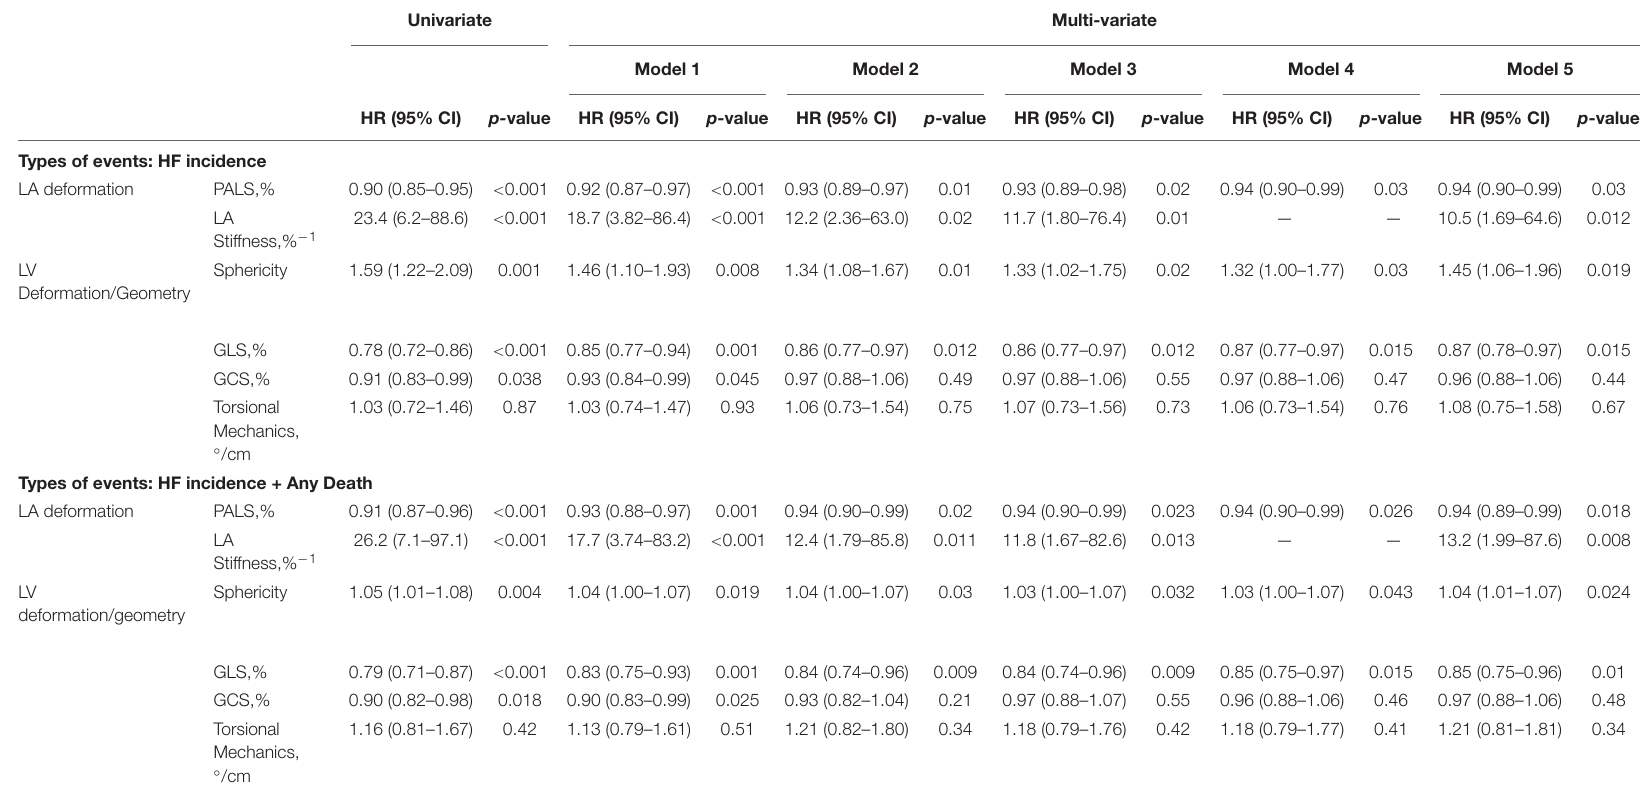
Model 1: adjusted for age. Model 2: adjusted for age, BMI, heart rate, SBP, eGFR, hypertension, diabetes, CAD and active smoking. Model 3: adjusted for age, BMI, heart rate, SBP, eGFR, hypertension, diabetes, CAD and active smoking, LVEF. Model 4: adjusted for age, BMI, heart rate, SBP, eGFR, hypertension, diabetes, CAD and active smoking, E/e’. Model 5: adjusted for age, BMI, heart rate, SBP, eGFR, hypertension, diabetes, CAD and active smoking,